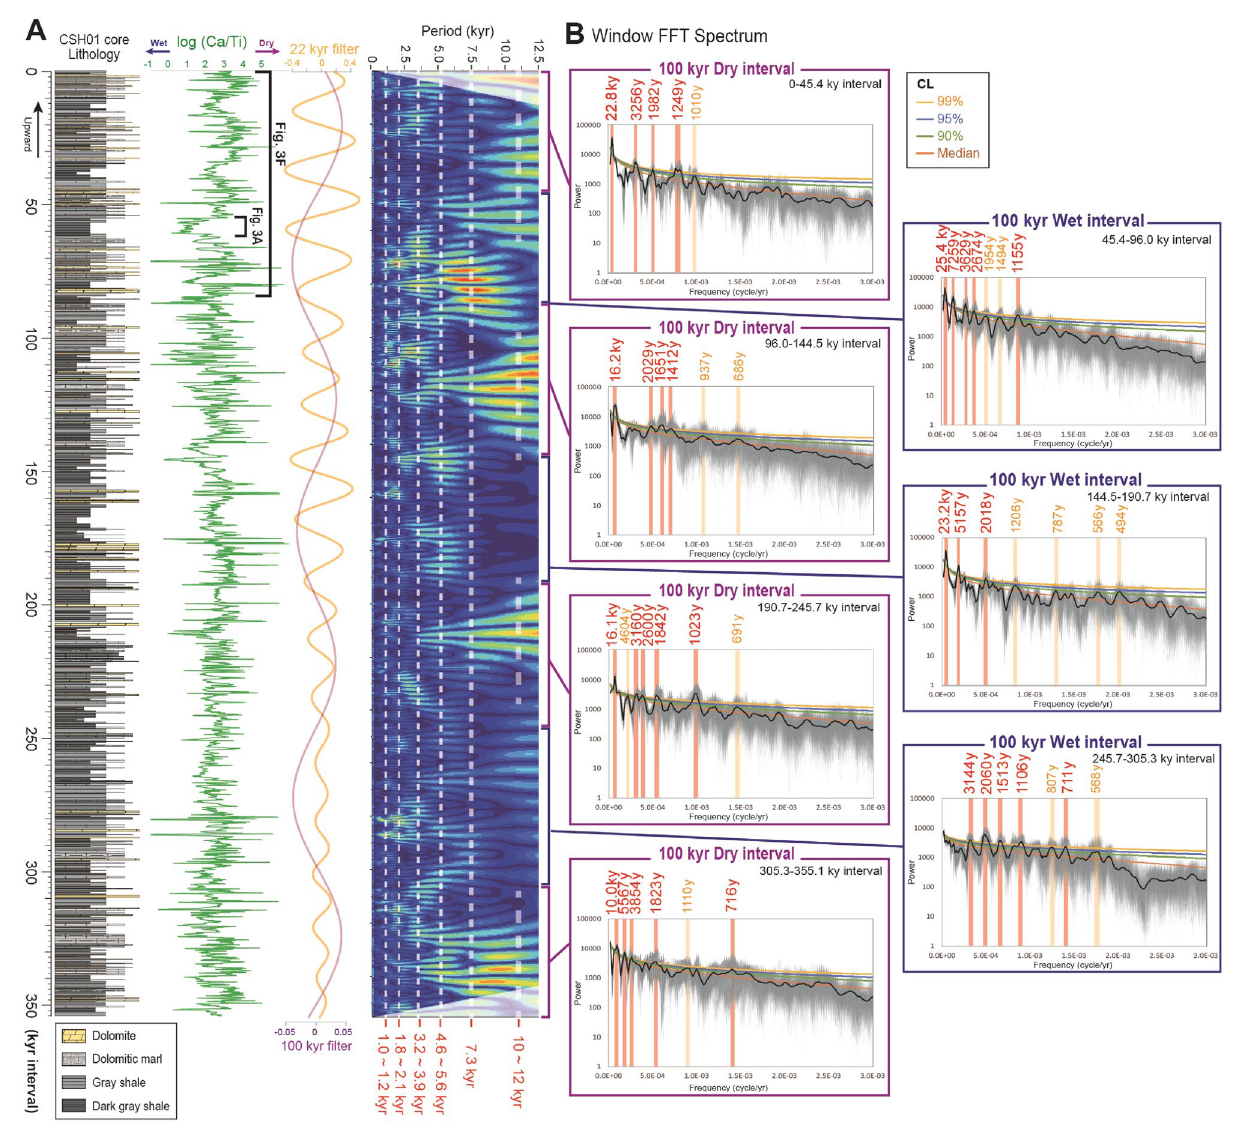
Figure 4. Decadally resolved changes in Ca/Ti ratios for a ~ 355-kyr interval. ( A ) Lithology, Ca/Ti ratios and wavelet analysis for a 29.6 m-thick (~ 355-kyr) interval of core CSH01 at 500 μm (~ 6 year) resolution using a XRF core scanner (Cox, Itrax). Amplitude modulation of 22-kyr filter (yellow; frequency: 4.5e-5; bandwidth: 1.0e-5) and 100-kyr filter (purple; frequency: 9.5e-6; bandwidth: 1.5e-6) are also shown. ( B ) Window FFT analyses of Ca/Ti variations for the drier interval and wetter interval of 100-kyr eccentricity minimum/ maximum. Results of the Monte Carlo 1000 random runs concerning uncertainties of relative age estimations (Fig. S7) are shown as semitransparent grey lines. Significances of Fourier power spectrum are estimated for median values (black thick lines) only, assuming that subject power spectrum contains red-noise back ground signal. Reddish bars and numbers indicate significant spectral peaks above 99% CL. Yellowish bars and numbers indicate moderate spectral peaks above 90% CL. Window FFT analysis reveals pronounced but quasi-periodic millennial-scale periodicities centering on ~ 1010–1023, 1106–1155, 1206–1249, 1412–1513, 1823–2060, 3160– 3854, 4604–5567, and ~ 7259 years, and less-pronounced centennial-scale periodicities of ~ 566–568, 686–716, and 787–810